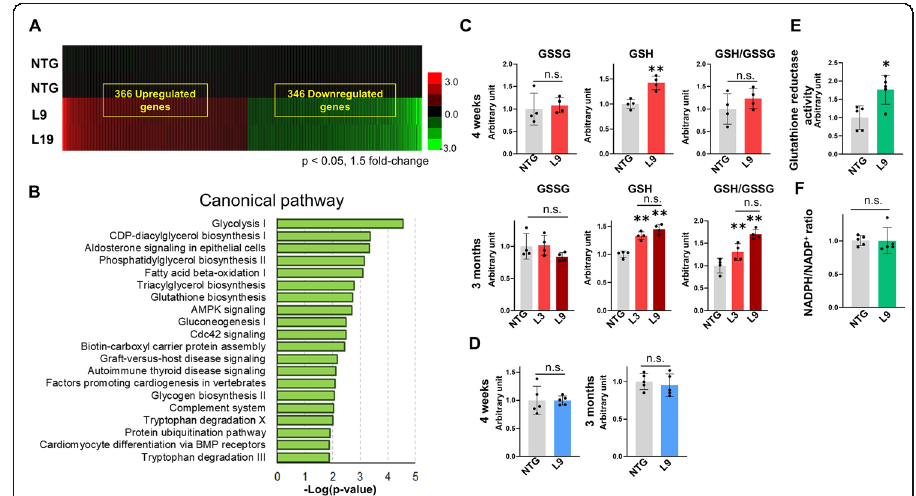
Fig. 4 cDNA microarray examination and redox analysis of α MHC/miR-143/145TG mice. a Fold changes in gene expression over the average of the male NTG control mice are as indicated on the scale bar, where red indicates upregulation and green indicates downregulation. The number of genes > 1.5-fold differentially expressed in male L9 and L19 mice over control NTG are indicated. b Gene ontology classification of genes differentially expressed at least 1.5-fold in male L9 and L19 mice compared to the NTG control. The top twenty most significant canonical pathways in L9 and L19 mice are shown. c GSSG, GSH and GSH-to-GSSG ratio of 4-week and 3-month old male L3 and L9 mice. The results are presented as the means ± SD. Significance was assessed with unpaired t -test or one-way ANOVA followed by a post hoc Tukey test ( n = 4; ** p < 0.01 vs. NTG). d TBARS assay of 4-week and 3-month old male L9 mice. The results are presented as the means ± SD. Significance was assessed with unpaired t -test ( n = 5). e Glutathione reductase assay of 3-month-old male L9 mice. The results are presented as the means ± SD. Significance was assessed with unpaired t -test ( n = 5). f NADPH/NADP + assay of 3-month old male L9 mice. The ratios of NADPH to NADP + are shown. The results are presented as the means ± SD. Significance was assessed with unpaired t -test ( n = 5). c – f Similar results were obtained in at least two independent